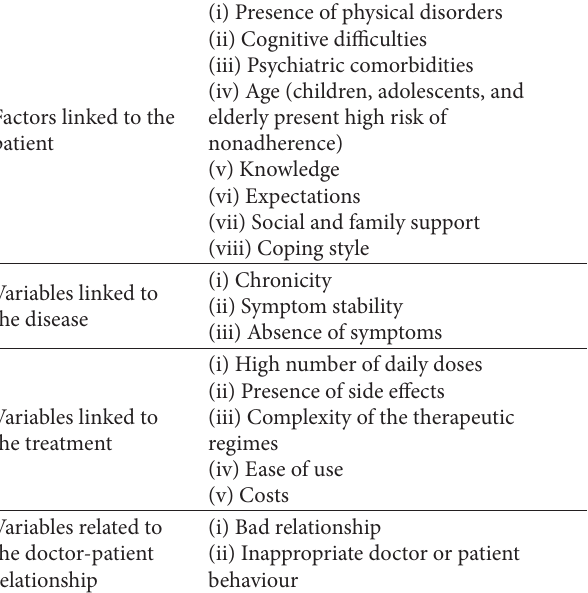
Table 2: Causes of